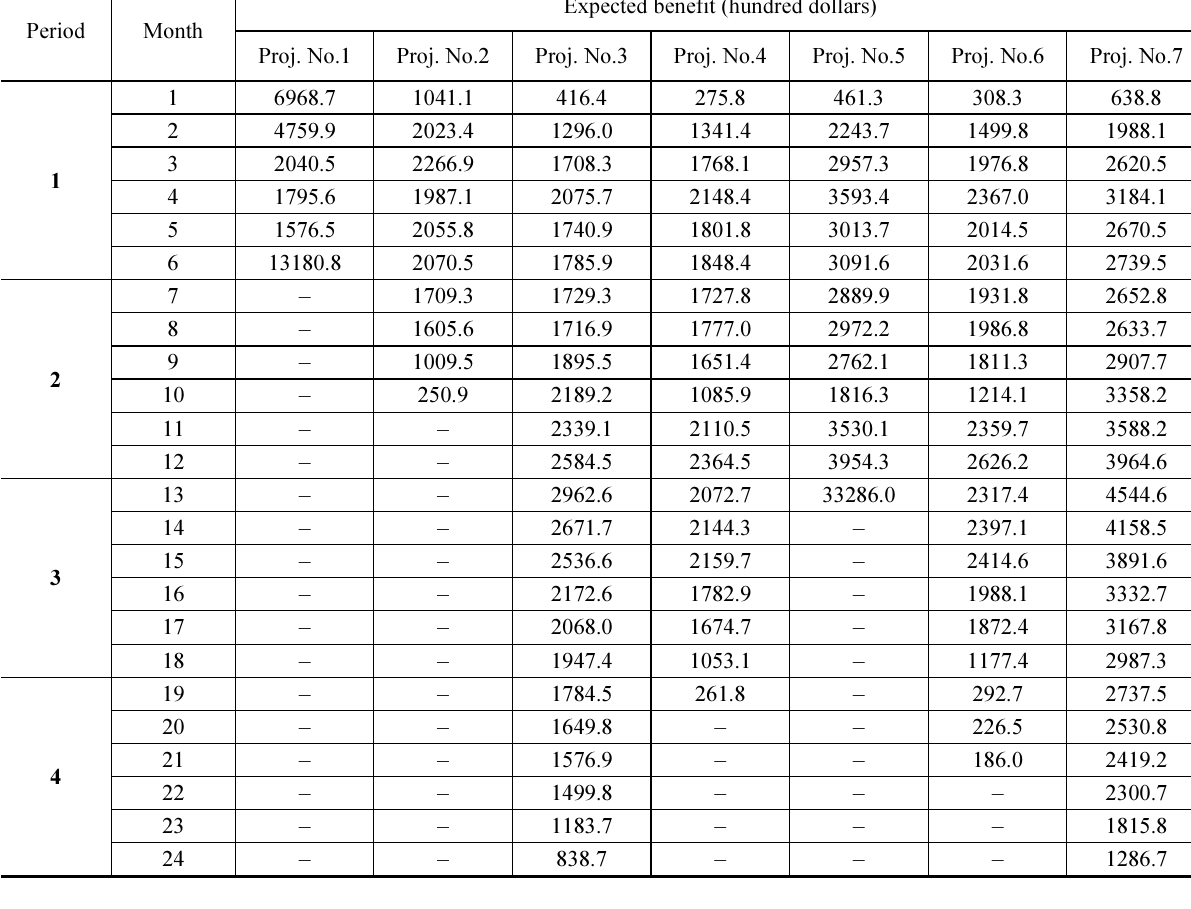
Table 8. The results on altering weight of goals